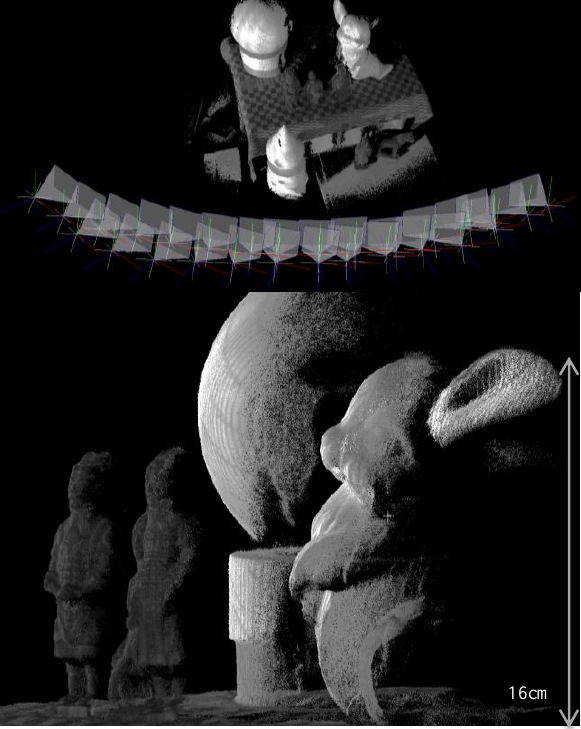
Figure 7: Multi-view acquisition result of comparable scene, containing a sphere with 7.5cm radius at about 60cm distance (7.1°). The standard deviation to the best fitting sphere amounts to 0.25mm.